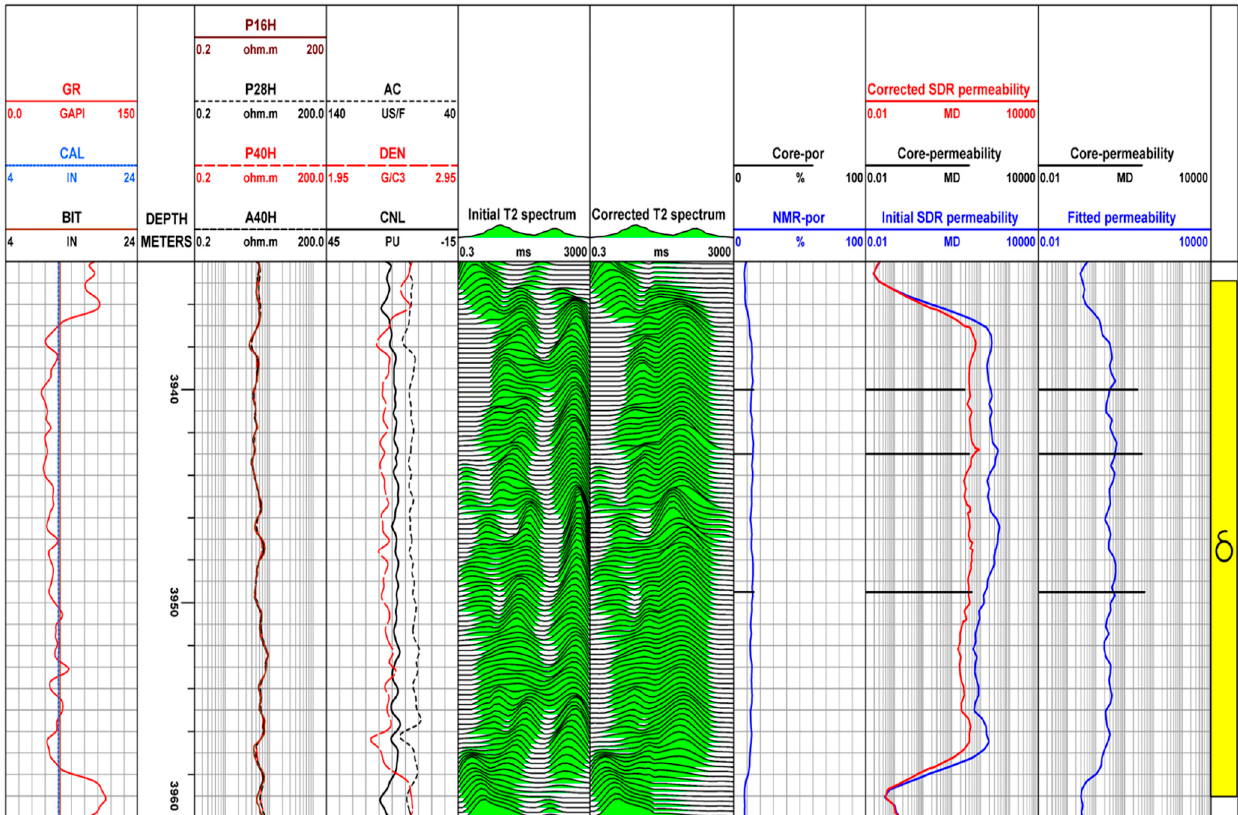
Figure 8. A field example of correcting the invasion of oil-based mud to field NMR logging in well C. In the first track, the displayed curves are gamma ray (GR), borehole diameter (CAL), and bit diameter (BIT). The second track is the depth. The third is resistivity curve. The acoustic transit time log (AC), the density log (DEN), compensated neutron log (CNL) are shown in the fourth track. The fifth track is the initial measured T 2 spectrum of NMR logging before correction (Initial T 2 spectrum). The T 2 spectrum of nuclear magnetic resonance logging (Corrected T 2 spectrum) under the condition of water-based mud corrected by the method proposed in this study is displayed in the sixth track. The NMR calculated porosity (NMR-por) and core analysis porosity (Core-por) are shown in the seventh track and have good consistency. The Corrected SDR permeability is calculated permeability from the corrected T 2 spectrum by using Schlumberger-doll-Research (SDR) model, and the Initial SDR permeability is estimated permeability from the Initial T 2 spectrum by using SDR model, the Core-permeability is derived permeability from core analysis. The ninth track is the permeability calculated by using the traditional porosity-permeability relationship (Fitted permeability). Good consistency of estimated permeability from Corrected T 2 spectrum with core derived permeability illustrates the reliability of the proposed method.